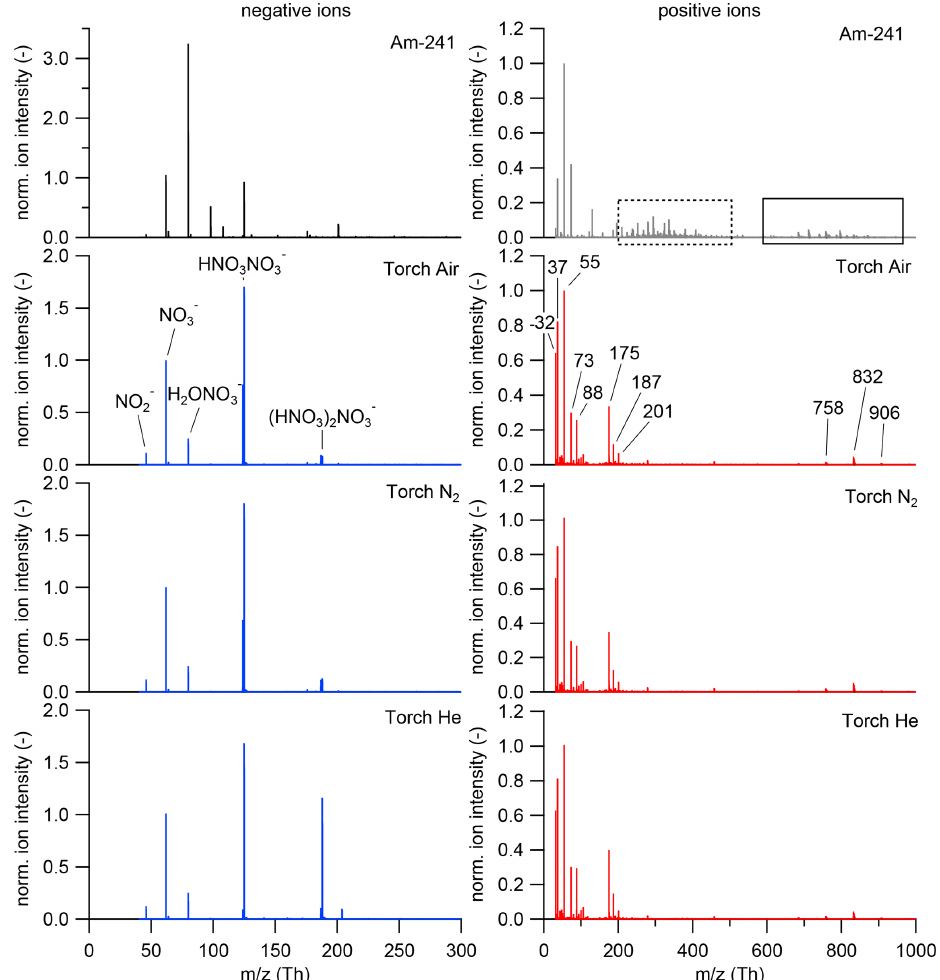
Figure 4. Negative (left) and positive (right) mass spectra of ions generated by the 241 Am charger (first panel) and the plasma source for three different working gases, synthetic air (second panel), N 2 (third panel) and He (fourth panel) were measured using the setup in the upper panel of Figure 2. The mass spectra were averaged over 1h each. The identified compounds are labelled in the second panel and are presented in Table 3. The negative mass spectrum was normalized to the NO − ion (integer mass 62 Th); the positive mass spectrum was normalized to 3 the ( H 2 O ) 2 · H 3 O + cluster (integer mass 55Th). The H 3 O + ion is not displayed here since it was not covered by the set mass range of the ioniAPi-TOF. The dashed square box marks unidentified masses in the positive 241 Am mass spectrum, and the solid square box shows the silicone compounds that are listed in Table